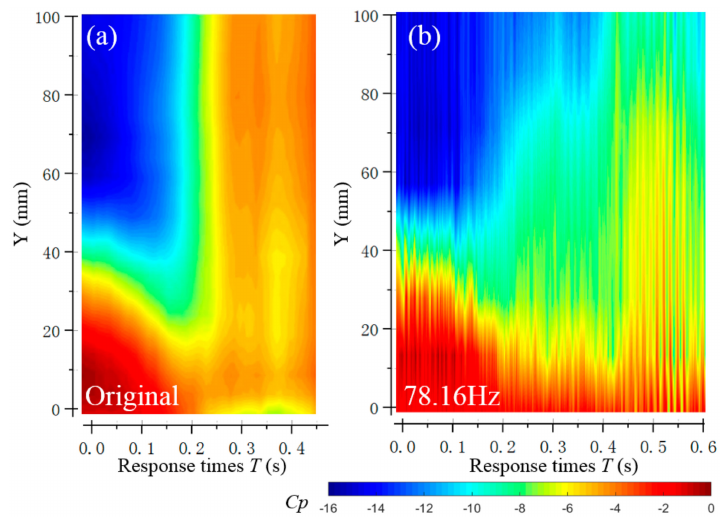
Figure 20. Nephogram of dynamic pressure change on S1 section. ( a ) Original working condition; ( b ) adding 78.16 Hz pulsed